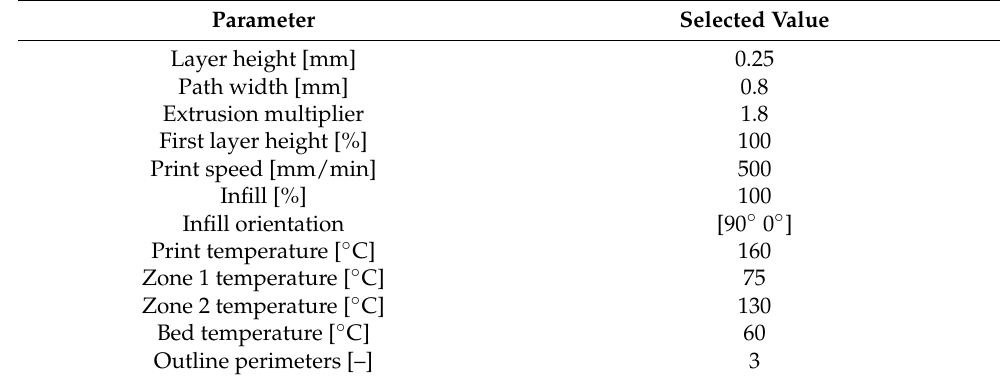
Table 2. List of relevant slicing parameters.